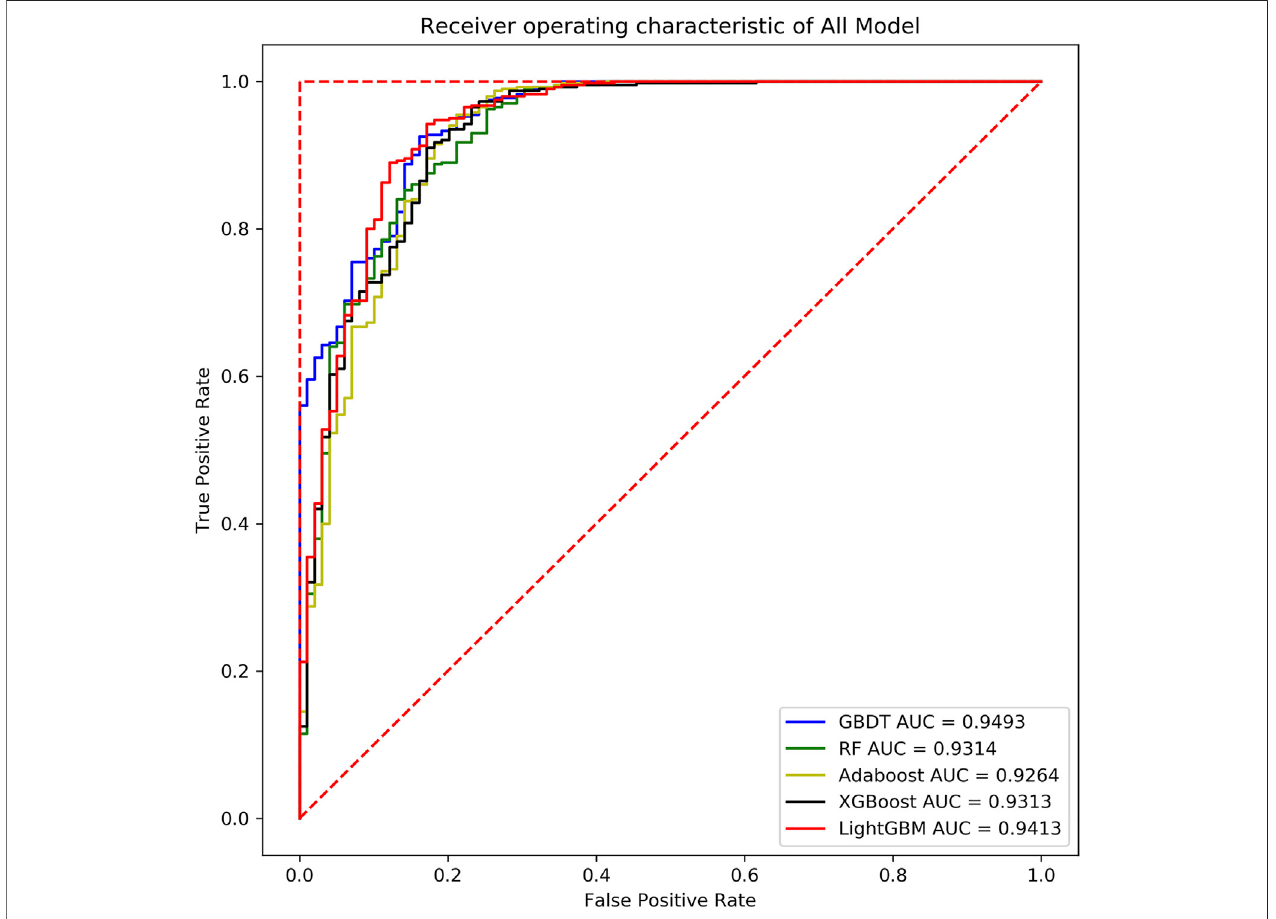
FIGURE 10 | ROC curves of fi ve models of Botrytis cinerea